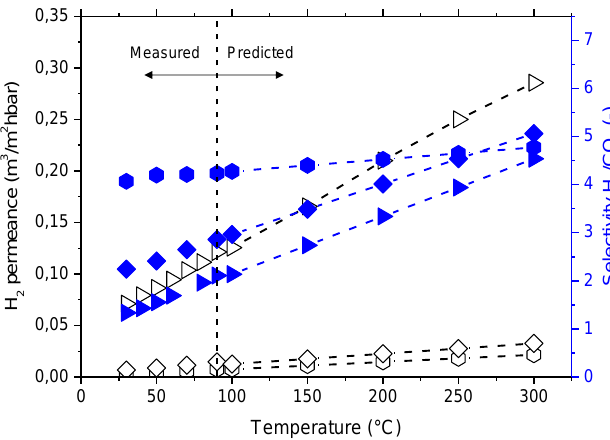
Figure 13. Evolution and prediction of the permeance and selectivity as a function of the process temperature conditions for 10% concentration of polymer. Open symbols represent the permeance (on the left y -axis) and filled symbols represent selectivity (on the right y -axis). Hexagons represent P84 ® , diamonds Matrimid ® , and triangles 6FDA-6FpDA.